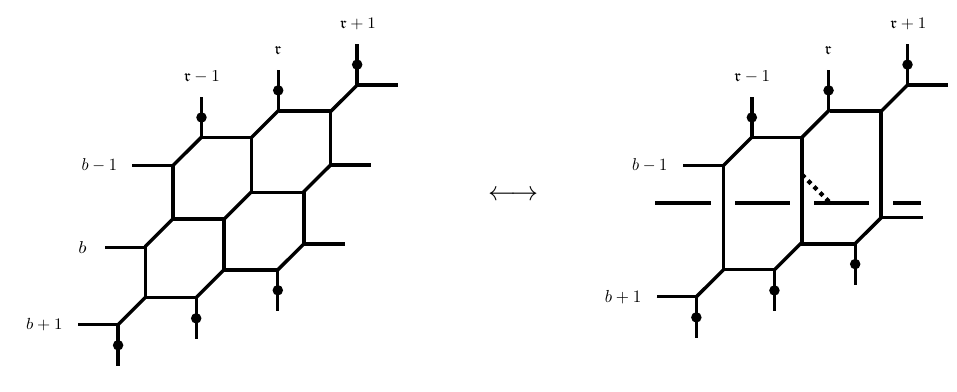
Figure 2 . The geometric transition operated on the unpreferred direction. The horizontal axis is compacti(cid:12)ed and the dots indicate the preferred